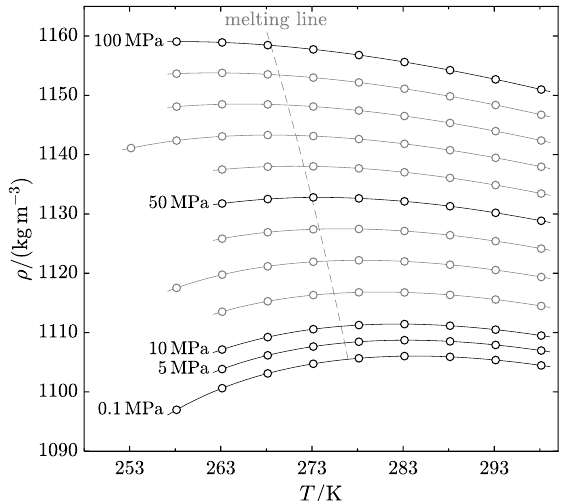
Fig. 3. Density isobars of heavy water.